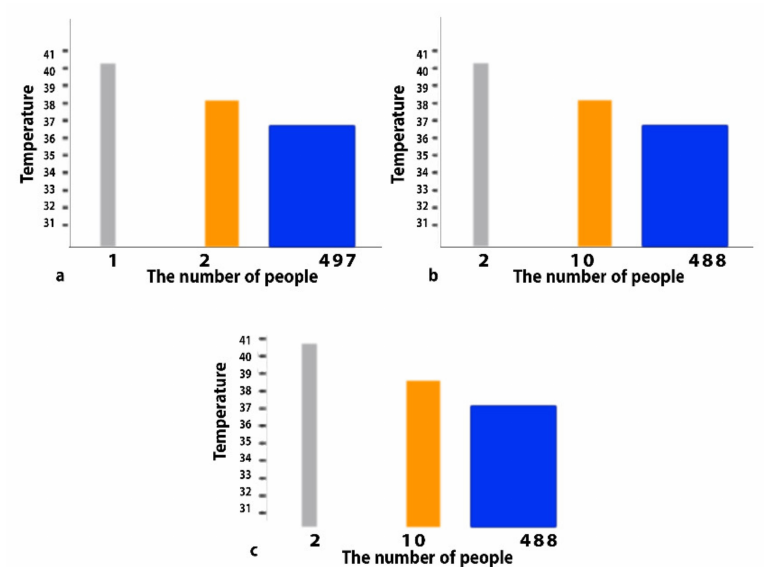
Figure 5. Temperature measurement analysis using MATLAB. ( a ) The temperature readings for the first time when all the people were examined. ( b ) The temperature readings for the second time when all the people were tested. ( c ) The temperature readings for the third